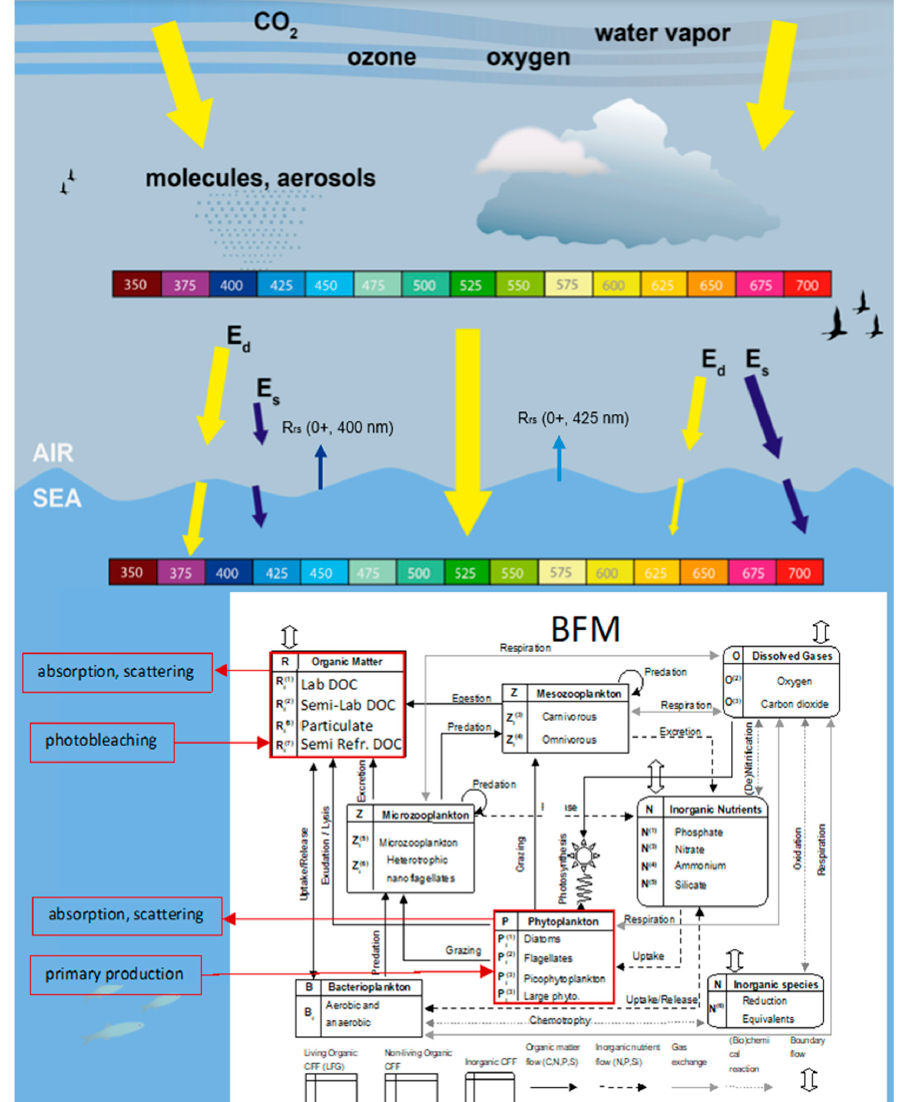
Figure 1. Schematics of the biogeochemical model interactions with the multispectral light